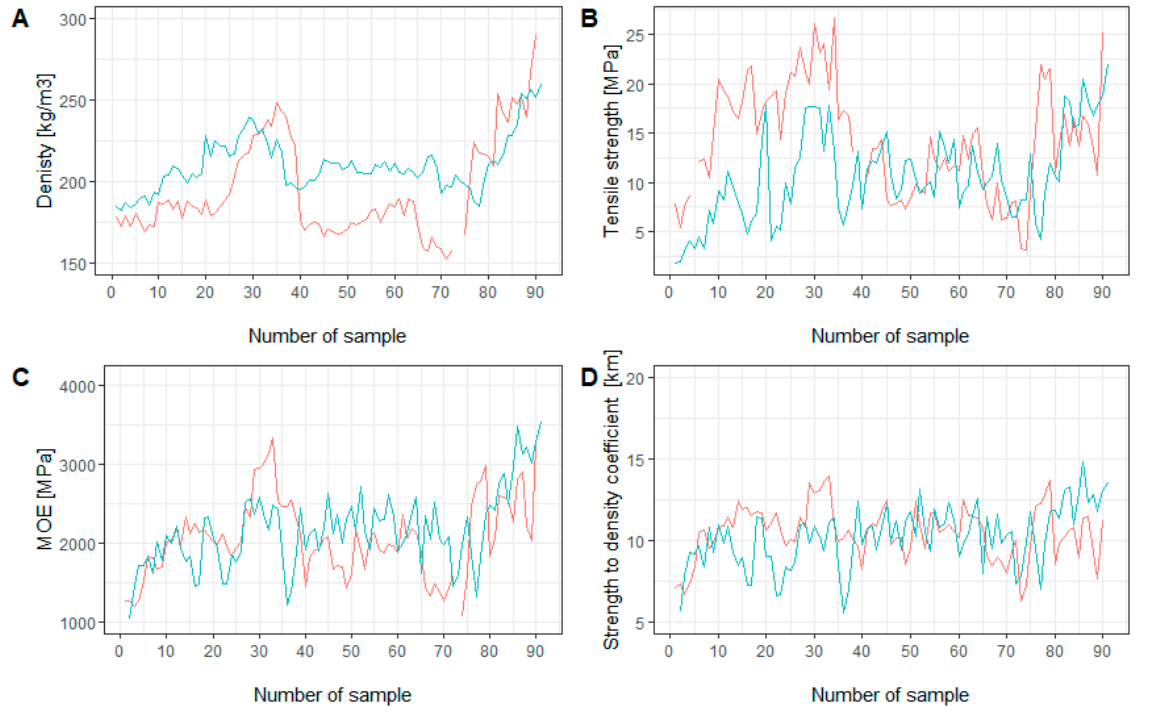
Figure 5. Cross-section comparison of examined properties from the ground section: ( A ) density [kg/m 3 ]; ( B ) modulus of rupture [MPa]; ( C ) modulus of elasticity [MPa]; ( D ) strength-to-density coefficient [km]. Sample no. 0 is from the pith, and 90 is at the bark. IG (red line): the first annual ring between samples 1 and sample 34, the second annual ring between samples 35 and 64, and the third annual ring between samples 65 and 90. IIIG (blue line): the first annual ring between samples 1 and sample 29, the second annual ring between samples 30 and 67, and the third annual ring between samples 68 and 91.